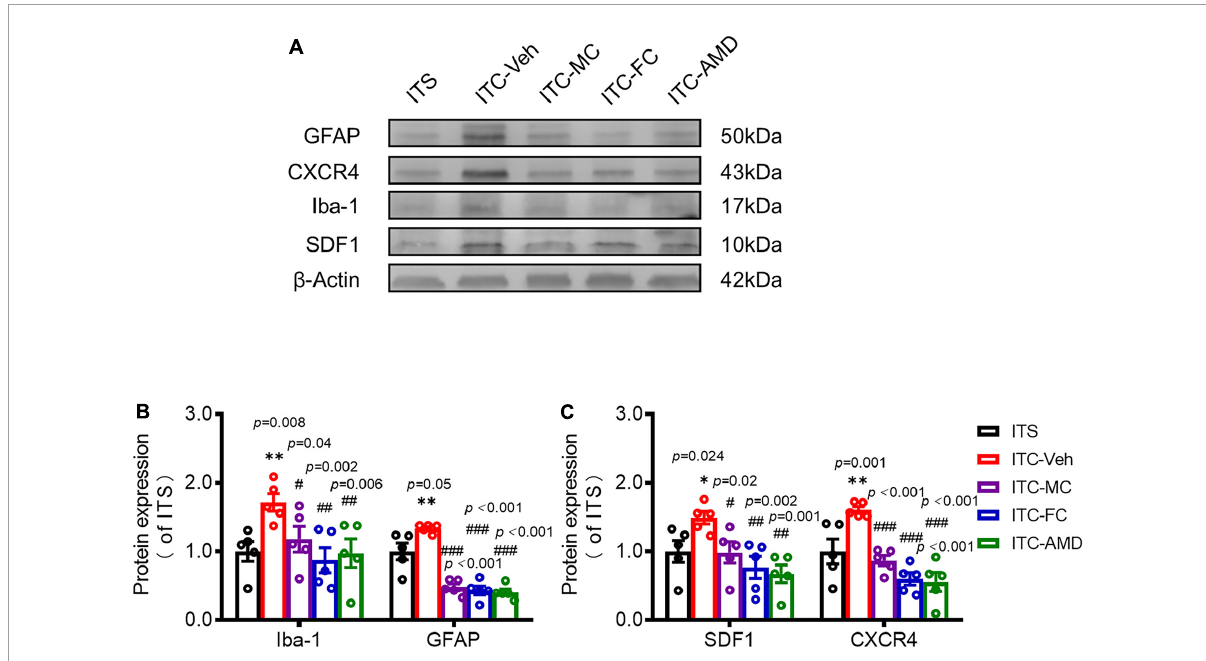
FIGURE7 Suppressing effects of i.t. antineuroinflammation treatment on expression levels of Iba-1, GFAP, SDF1, and CXCR4 in the spinal dorsal horn following ITS or ITC. Western blot assays (A) and quantitative analysis (B–C) of Iba1, GFAP, SDF-1, and CXCR4 expressions in the dorsal cord following i.t. administration of vehicle and drugs 10 days after ITS or ITC (3 days after i.t. catheterization). ITC-Veh, rats with ITC receiving i.t. administration of vehicle; ITC-MC, rats with ITC receiving i.t. administration of MC; ITC-FC, rats with ITC receiving i.t. administration of FC; ITC-AMD, rats with ITC receiving i.t. administration of AMD3100. * p < 0.05, ** p < 0.01, ITS vs. ITC-Veh; # p < 0.05, ## p < 0.01, ### p < 0.001, ITC-MC/ITC-FC/ITC-AMD vs. ITC-Veh; n = 5